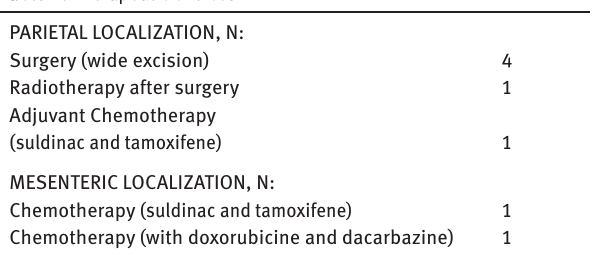
Table 2: Therapeutic